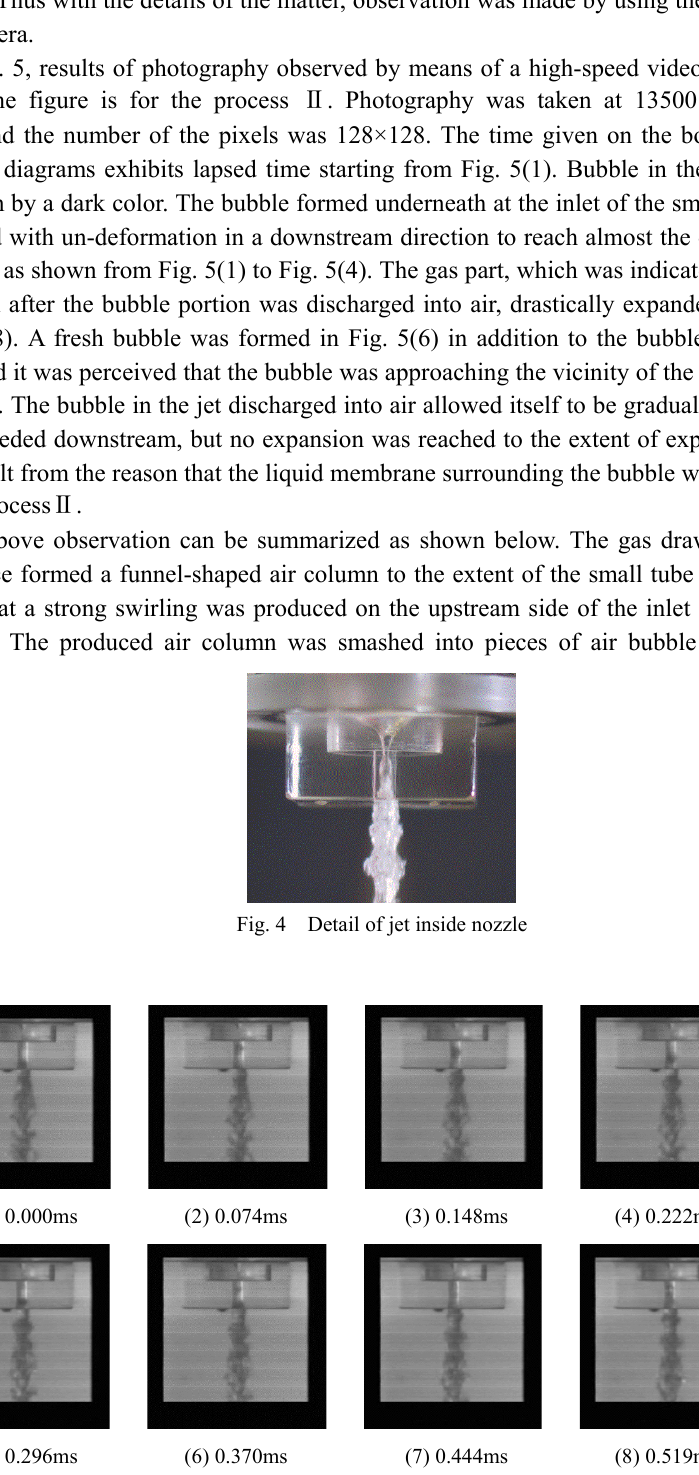
Fig. 5 Dynamic behavior of air-water jets with P a =0.05MPa